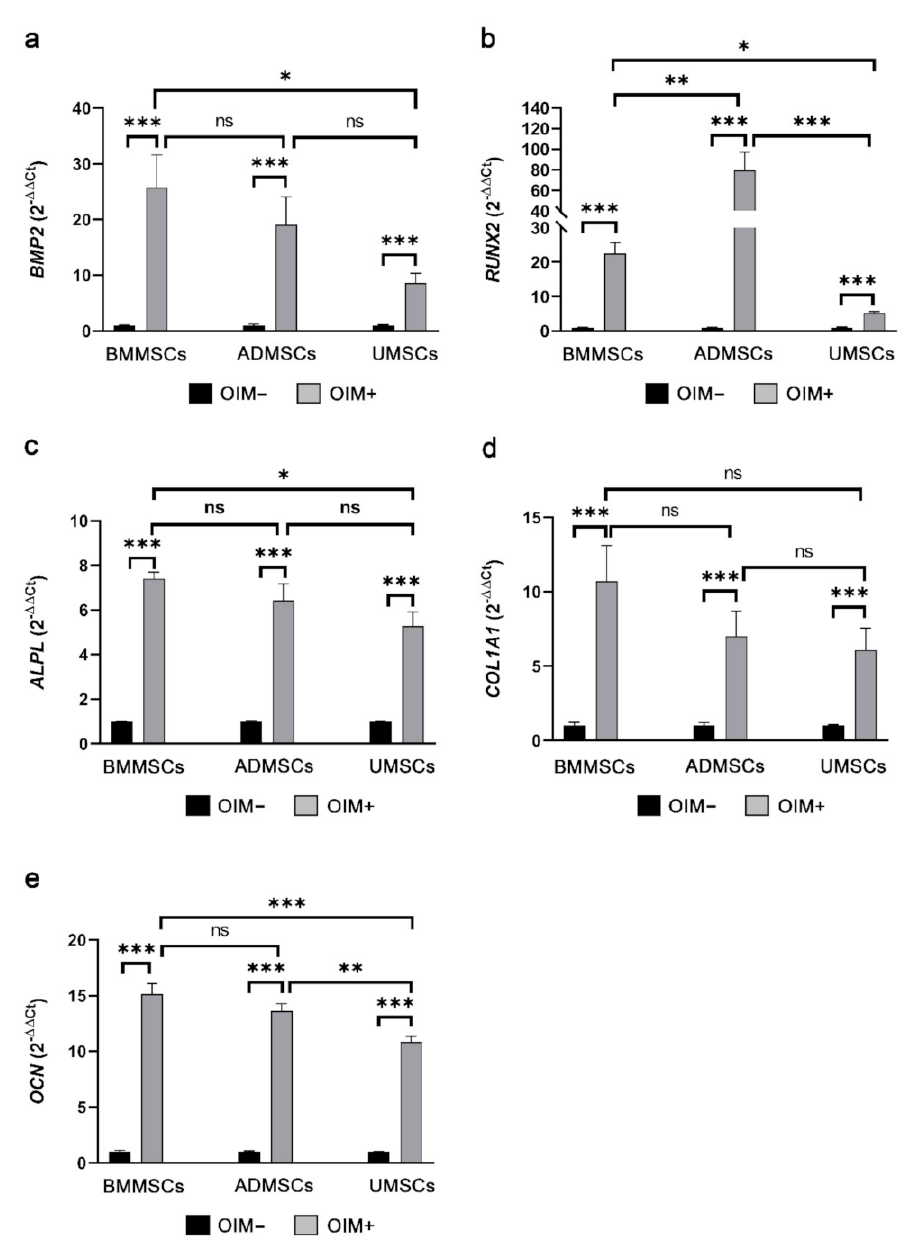
Figure 7. Real-time quantitative polymerase chain reaction analysis of osteogenic genes. Osteogenic genes BMP2 ( a ), RUNX2 ( b ), ALPL ( c ), COL1A1 ( d ), and OCN ( e ) were analyzed, with GAPDH as the reference gene. Data derived from the treatment with an osteogenic differentiation medium (OIM+) were normalized to the noninduced (OIM − ) groups. A one-way ANOVA with Turkey’s post hoc test was used to examine the differences between experimental groups. Bars indicate the mean ± standard error of the mean. Statistical significance is represented as * p < 0.05, ** p < 0.01, *** p < 0.001, and not significant